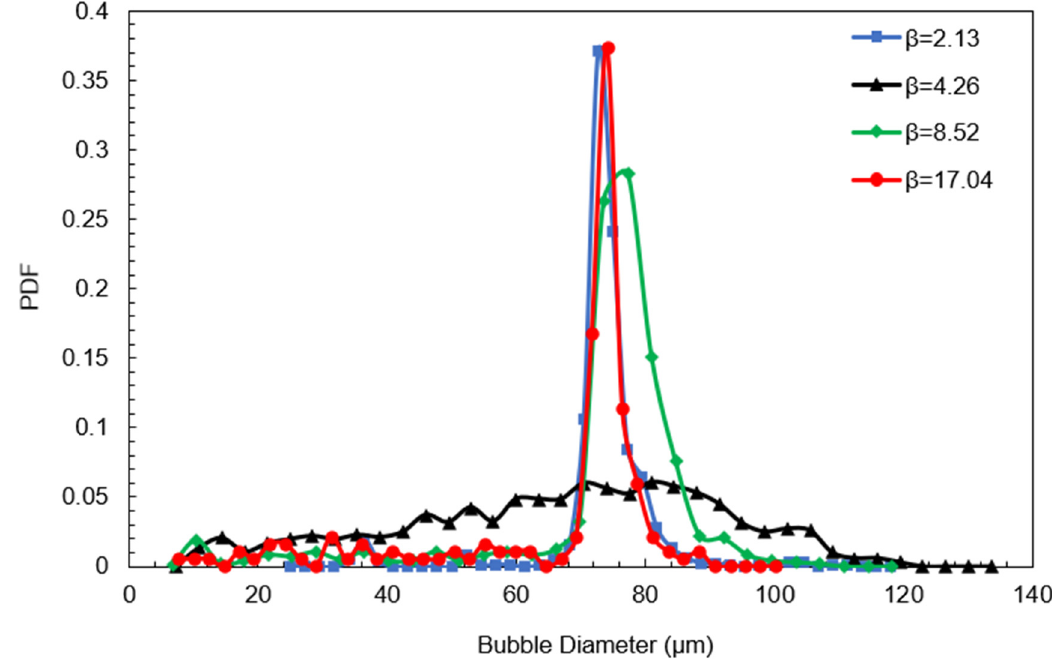
Figure 14. The pdf distribution of the bubble diameter at the outlet section of the diffuser. (Water flow rate = 8.21 L/min, air flow rate = 0.1 L/min).